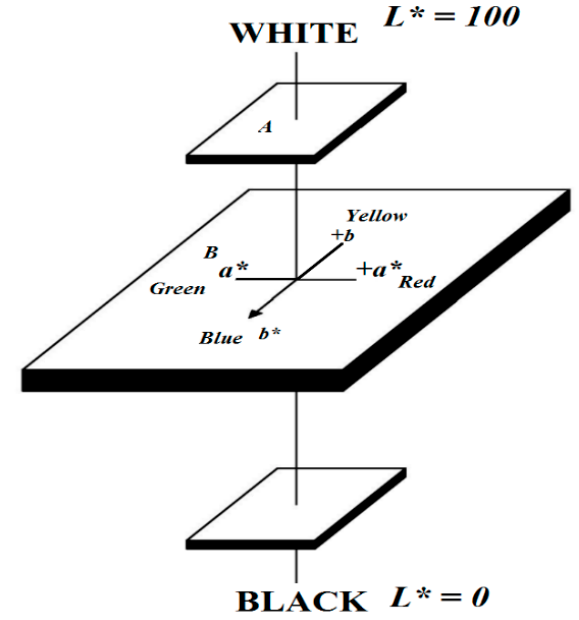
Figure 7. Color space defined by the L*, a*, b* axes. In addition, the deduced color parameter hue angle h is indicated (A: Color of occupation; B: Color of specimens; A’: Color of occupation at equal lighting as color of specimens).